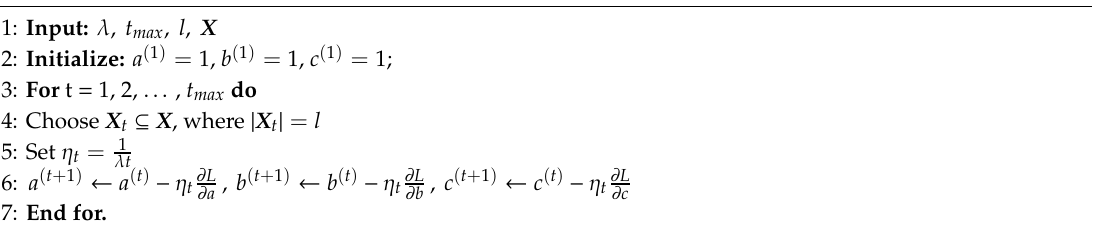
Algorithm 1 The stochastic sub-gradient descent for solving